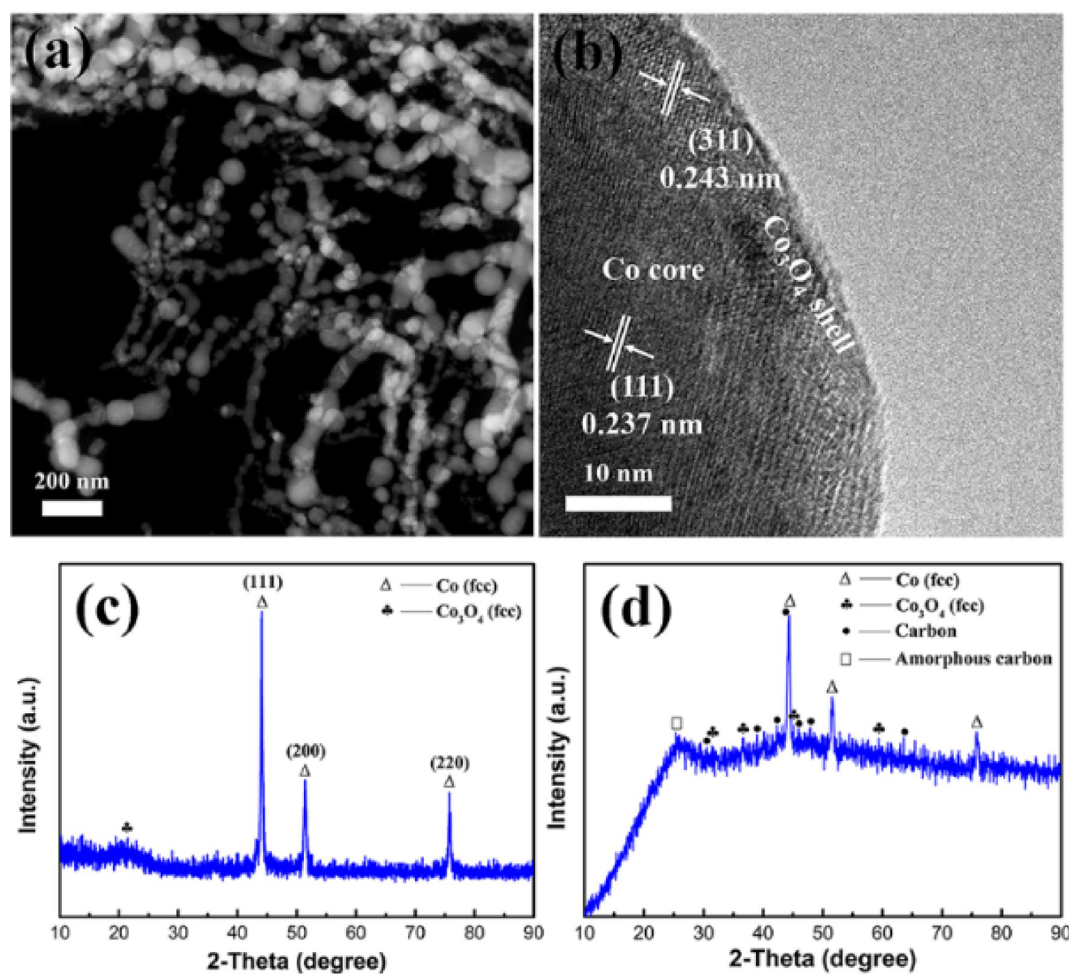
Figure 2. ( a ) STEM image, ( b ) HRTEM image, ( c ) XRD pattern of CoNPs, and ( d ) XRD pattern of